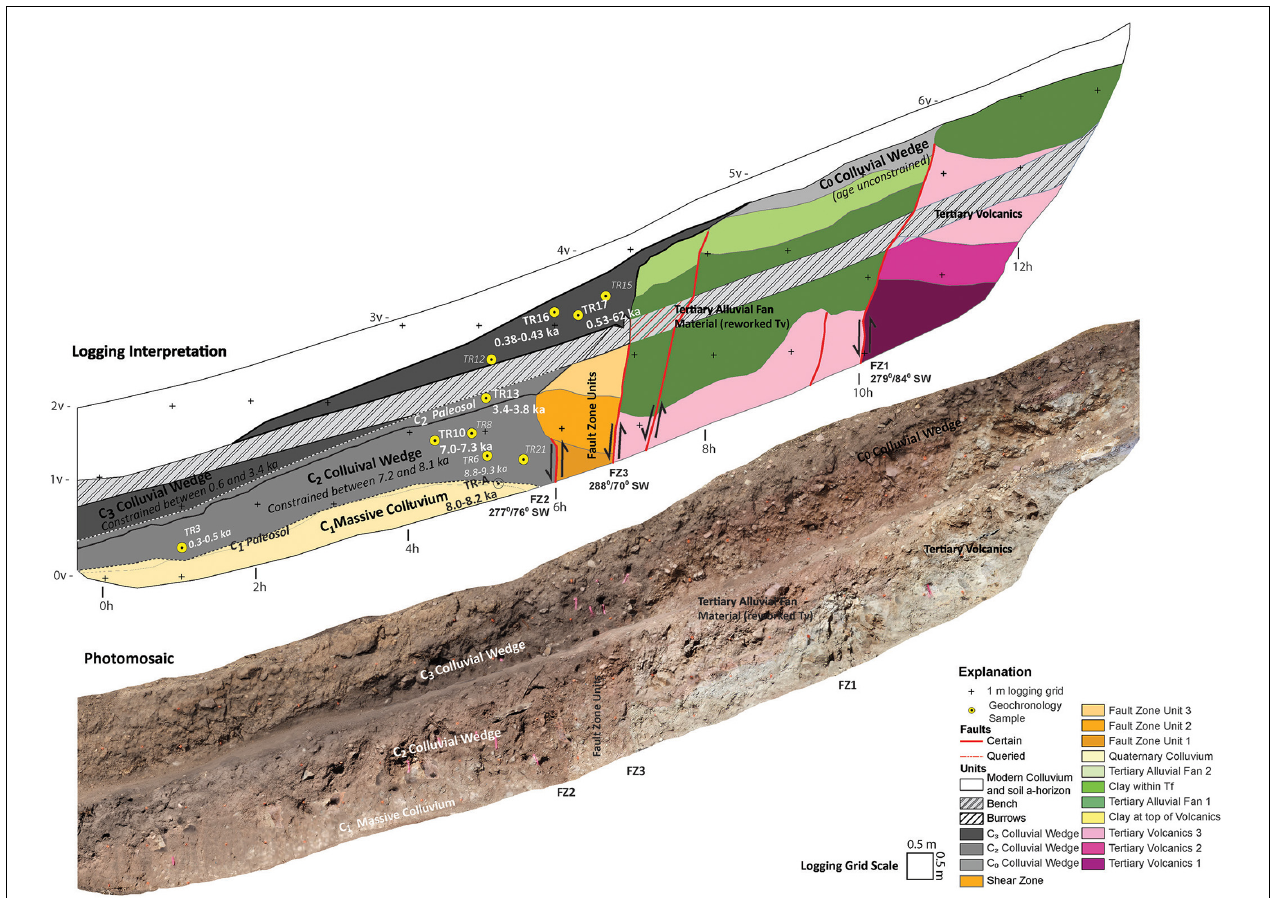
FIGURE 4 | Trench One North (T1N) west wall presents evidence for three earthquake-produced colluvial wedges (C 0 , C 2 , and C 3 ) along three fault zones. Ages are constrained for the C 2 and C 3 events. Samples TR16 (0.3 – 0.4 ka), TR17 (0.5–0.6 ka), and TR13a/b (3.4 – 3.5 ka and 3.6 – 3.8 ka) help constrain the age of the event that produced C 3 . Samples TR10a (7.0 – 7.3 ka), TR6 (8.8 – 9.3 ka), and TR-A (8.0 – 8.2 ka) help constrain the age of the event associated with C 2 ( Figures 7 , 8 and Table 1 ). Stratigraphic relations of supporting samples are observed on the T1N east wall ( Figure 3 ). Undated samples are shown in italics and smaller